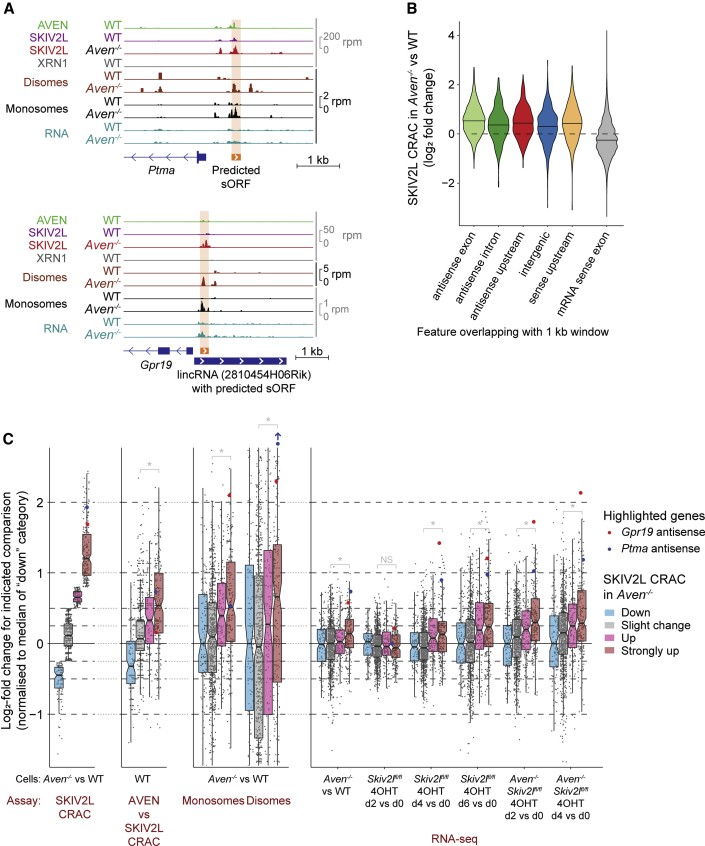
Small ORF Surveillance by AVEN and SKIV2L(A) CRAC, monosome, and disome profiling across ncRNA regions in WT and Aven−/− cells, with small ORFs indicated. RNA-seq of ribosome profiling inputs shown in blue.(B) SKIV2L CRAC changes (Aven−/− versus WT) for 1-kb genomic windows classified by overlap with protein-coding genes.(C) CRAC, ribosome profiling, and RNA-seq changes for the indicated comparisons, for non-coding 1-kb genomic windows defined in (B). Windows are categorized by their change in SKIV2L CRAC for Aven−/− versus WT cells (defined in the leftmost plot). The two genes in (A) are highlighted. ∗p < 10−4 (“Slight change” versus “Strongly up” categories; Mann-Whitney U test with Bonferroni correction).See also Figure S6 and Tables S6 and S7.